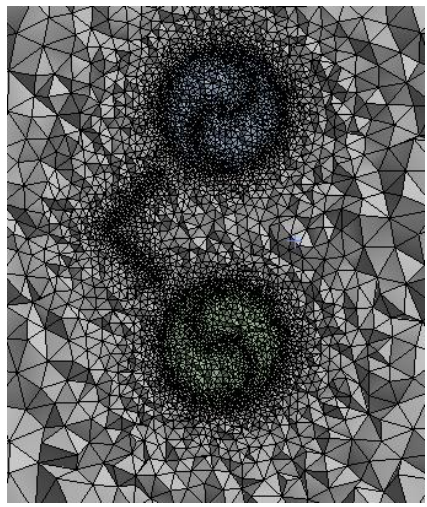
Figure 7. Mesh structure of dual turbine design.